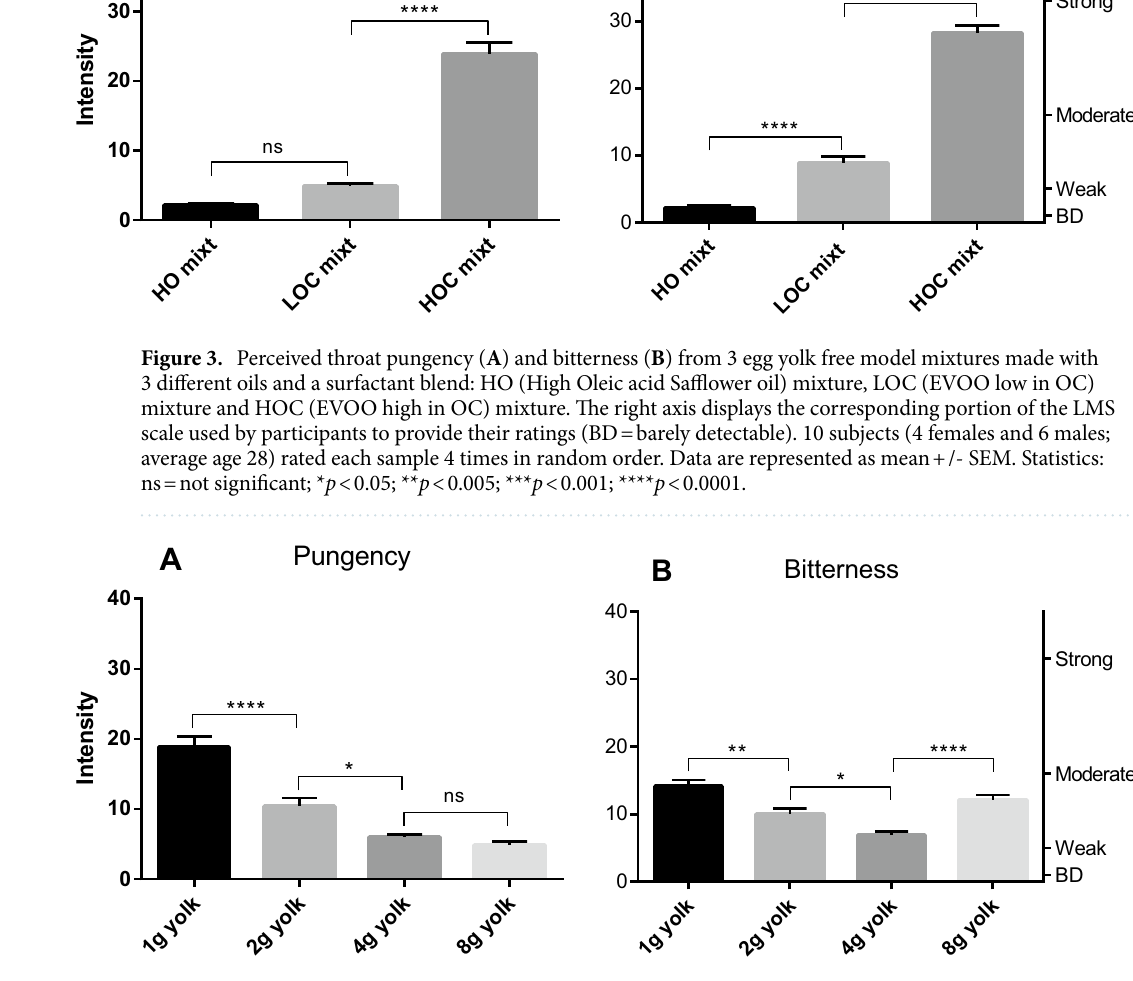
Figure 4. Perceived throat pungency ( A ) and bitterness ( B ) from model mayonnaises made with HOC (EVOO high in OC) and increasing amount of egg yolk (g/100 g oil). The right axis displays the corresponding portion of the LMS scale used by participants to provide their ratings (BD = barely detectable). 10 subjects (4 females and 6 males; average age 33) rated each sample 4 times in random order. Data are represented as mean + /-